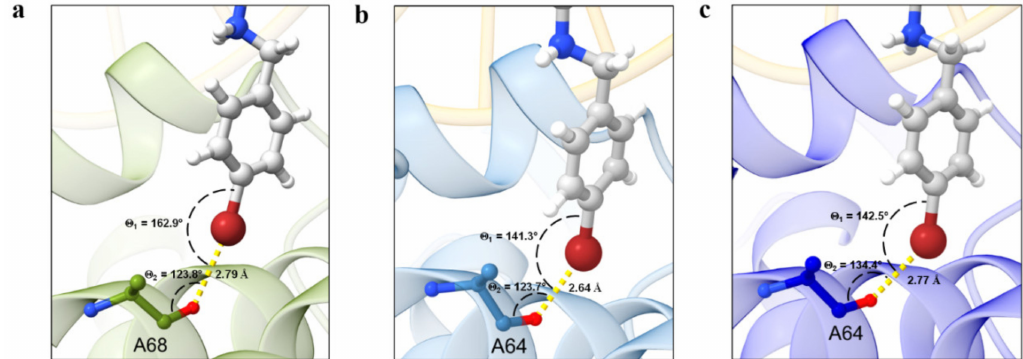
Figure 3. Halogen-bonding interactions for compound 14 as predicted by flexible molecular docking calculations within the RHS binding site of: ( a ) S. aureus DNA gyrase (PDB ID: 2XCS) [9], ( b ) S. aureus Topo IV homology model, and ( c ) E. coli Topo IV homology model. Enzymes are shown in green (DNA gyrase) and blue (Topo IV) ribbons, respectively, compound 14 is colored by element (ball and sticks representation), while DNA in pale orange. Halogen-bonding interactions are represented as yellow